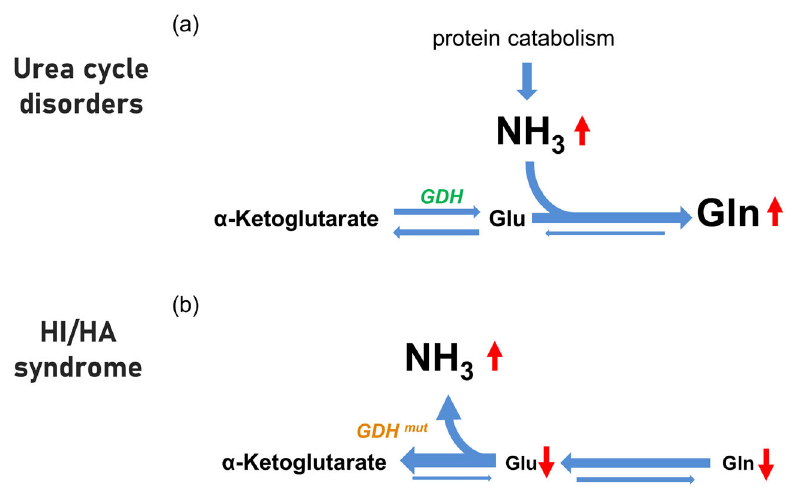
Figure 3. Schematic of the major pathways by which cerebral glutamate (Glu) and glutamine (Gln) levels are affected in urea cycle disorders ( a ) and hypothesis for HI/HA syndrome ( b ) related to increased activity of glutamate dehydrogenase (GDH). Relative changes in pool size of cerebral metabolites ( α -ketoglutarate, ammonia, glutamate, and glutamine) between different conditions are indicated by differences in font size. In ( a ) ammonia (NH 3 ) levels are primarily increased, and they drive the condensation reaction with glutamate to produce glutamine by glutamine synthetase; the α -ketoglutarate -glutamate-glutamine pathway is shifted towards to the right. In ( b ) we hypothesize that in HI/HA, the activating mutations in the GDH enzyme drive the deamination of glutamate to produce ammonia and α -ketoglutarate; thus, the α ketoglutarate-glutamate-glutamine pathway is driven towards the left, and there is no accumulation of glutamine. ( a ) adapted from [42]). HA, hyperammonemia; HI, hyperinsulinism.